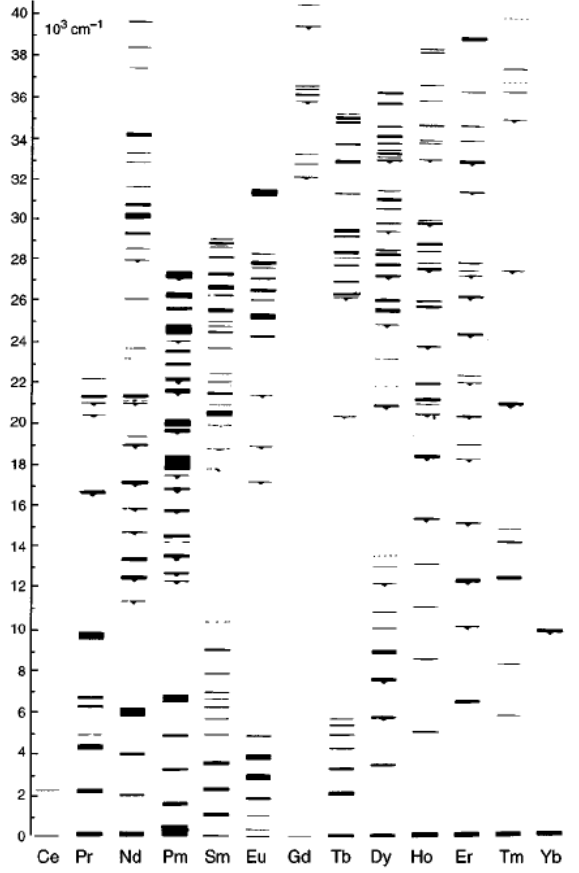
Figure 2 . Energy level diagrams for some various rare earth materials. Taken from Allison and Gillies